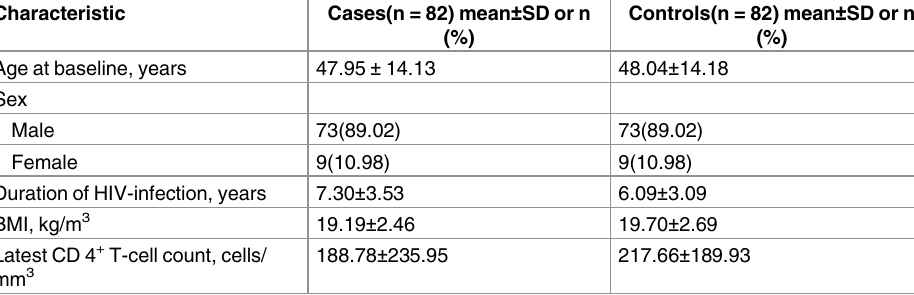
Table 2. Baseline characteristic of cases and